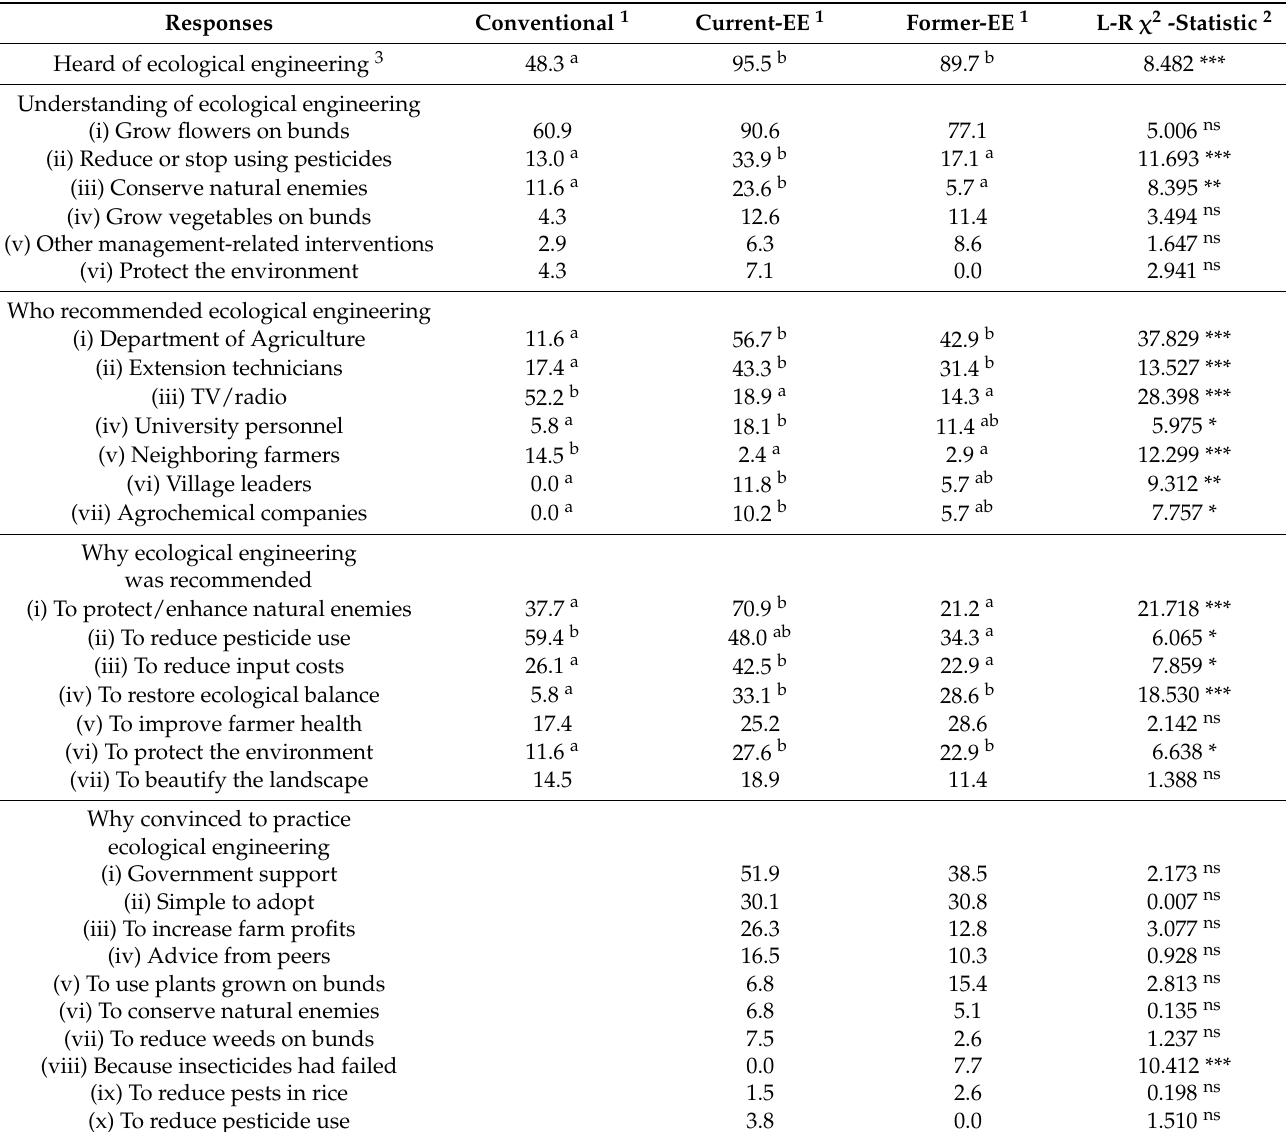
Table 1. Farmer exposure to information concerning ecological engineering for pest management and their responses to various objectives of the